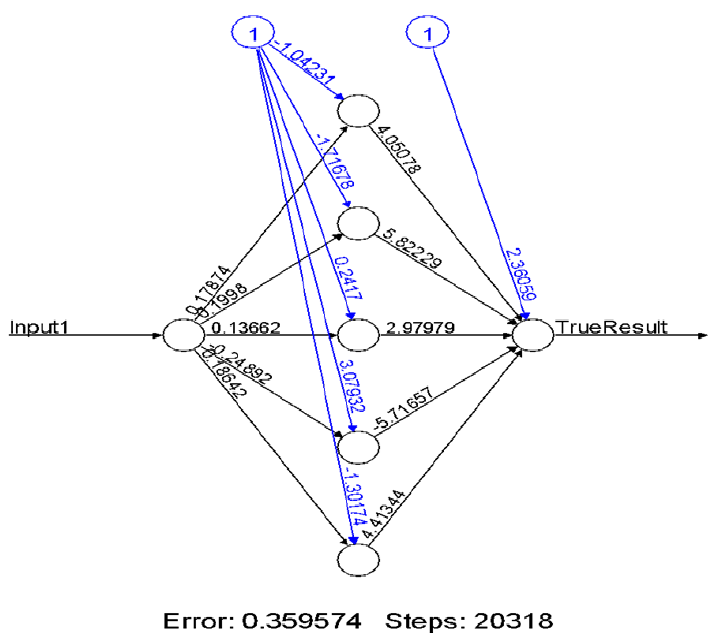
Figure 6. The Proposed Neural Network model with 1 hidden